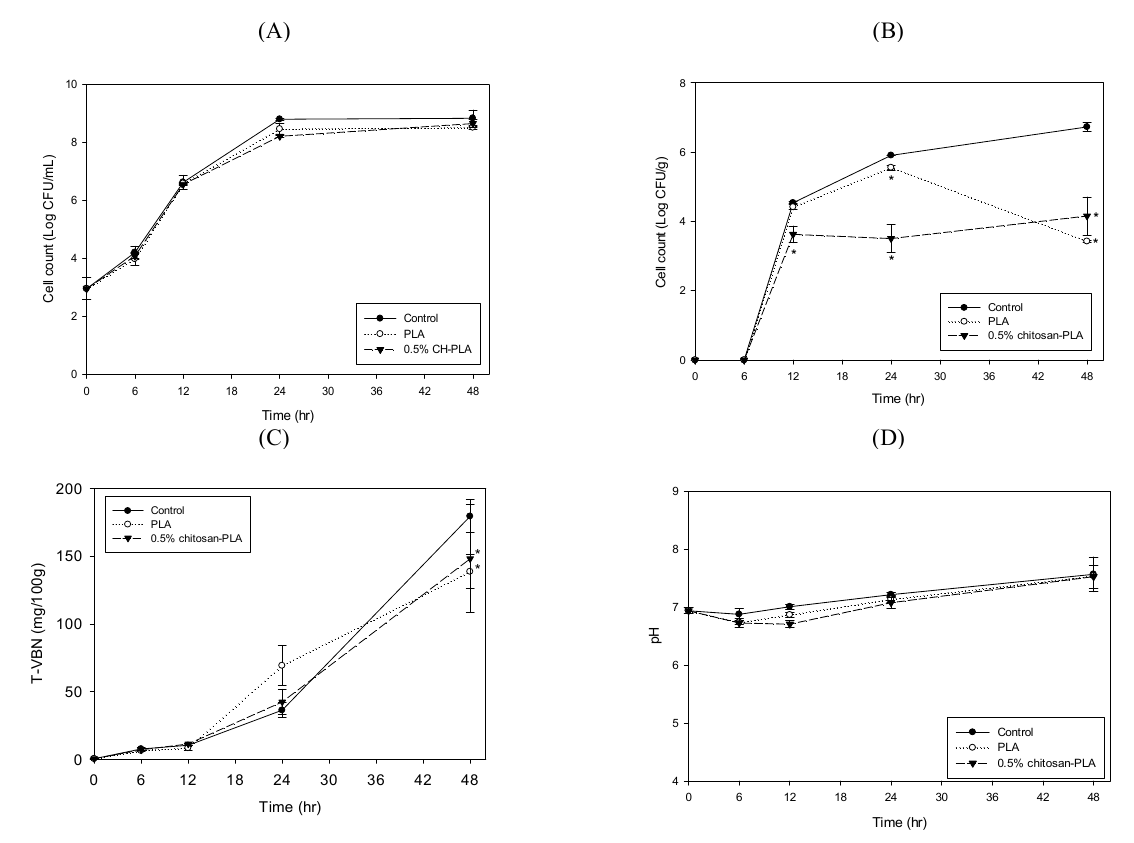
Figure 3. Changes in mesophilic count ( A ); psychrotrophic count ( B ); total volatile basic nitrogen content (TVBN) ( C ); and pH value ( D ) of fish fillet ( Epinephelus fuscoguttatus x Epinephelus lanceolatus ) uncovered (control) or covered with PLA or 0.5% CH–PLA films during storage at 25 °C. Data are presented as mean ± SD ( n = 3). * significantly different compared to control ( p < 0.05)